Question: Summarize what this figure shows in one sentence.
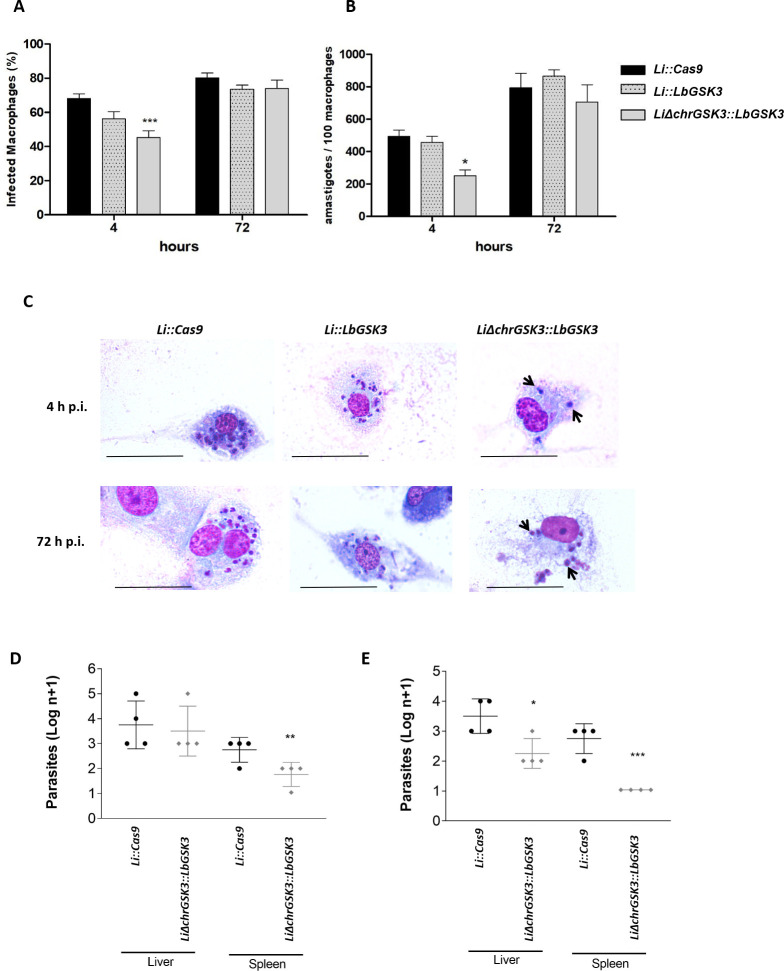
Answer: Impact of GSK-3s knockdown on L. infantum infectivity in macrophages and mice. Evaluation of Li::Cas9 and mutant ( LiΔchrGSK3::LbGSK3 ) parasite infectivity in macrophages at 4 and 72 h after infection. Infection was assessed as the percentage of infected macrophages at 4 and 72 h post-infection ( A ) and the number of amastigotes per 100 macrophages ( B ). The results are representative of three independent experiments performed in triplicate. Representative micrographs of THP-1-derived macrophages infected with parasites at 4 and 72 h post-infection (p.i.), stained with rapid panoptic ( C ). Scale bar: 50 µm. Parasite load in mice infected with Li::Cas9 and LiΔchrGSK3::LbGSK3 . Parasite burden was quantified by limiting dilution from samples isolated from the liver and spleen of BALB/c ( D ) and IFN- γ ⁻ /⁻ C57BL/6 mice ( E ). BALB/c and C57BL/6 mice were intravenously inoculated (via tail vein) with 2 × 10 7 late–log-phase promastigotes from either the Li::Cas9 or the LiΔchrGSK3::LbGSK3 lines. Samples were collected on day 20 post-infection. Statistical analysis was performed using analysis of variance followed by Bonferroni’s multiple comparisons test ( * P < 0.05, ** P < 0.01, *** P < 0.001).